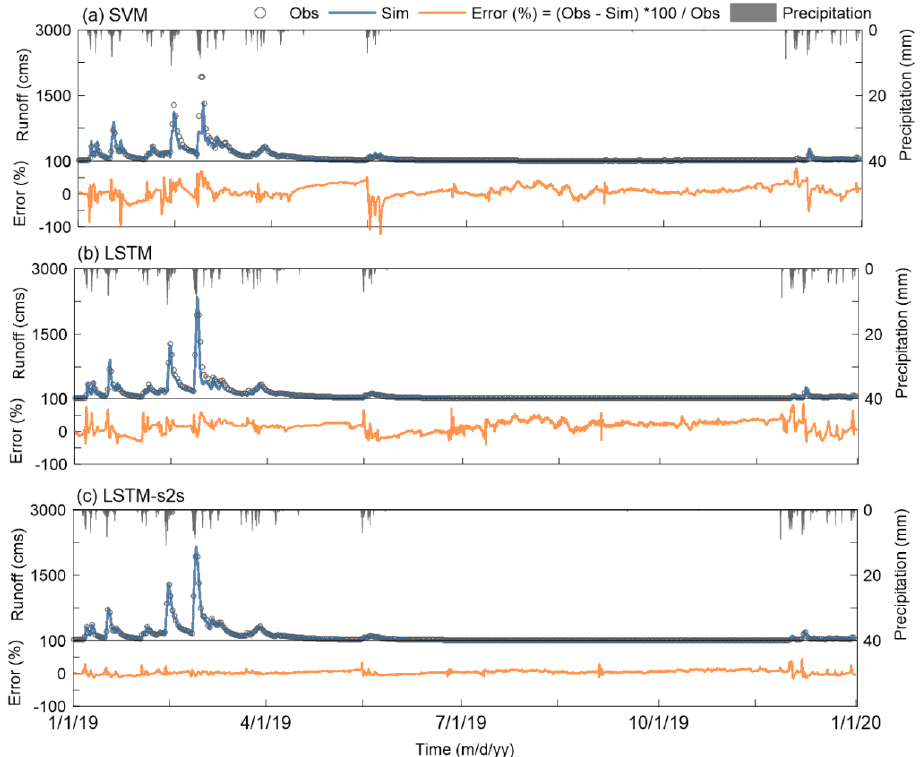
Figure 4. Observed and predicted runoff and errors with lead time of 1 h from three data-driven models. ( a – c ) indicate the results of SVM, LSTM, and LSTM-s2s models.